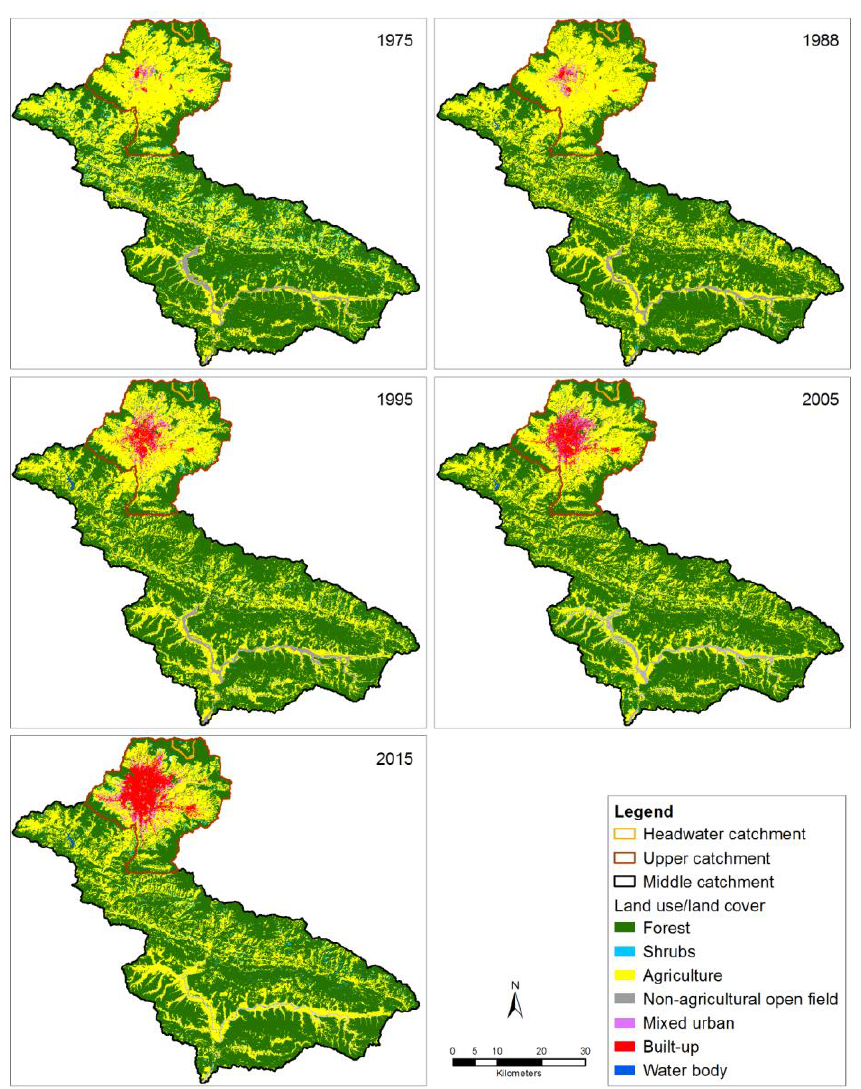
Figure 2. Land use / land cover in the Bagmati catchment—1975, 1988, 1995, 2005 and Figure 2. Land use/land cover in the Bagmati catchment — 1975, 1988, 1995, 2005 and 2015.